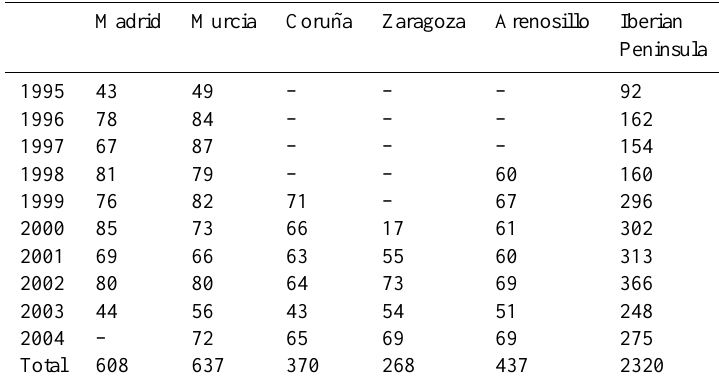
Table 1. Pairs of Brewer-GOME data considered in the comparison by year and location. Madrid